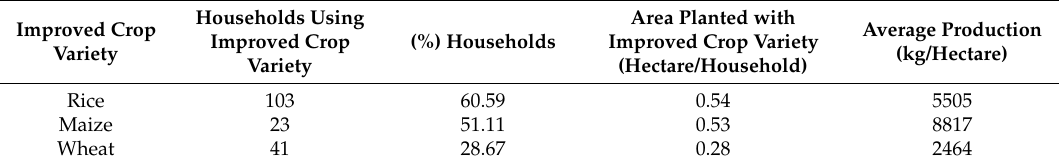
Table 13. Field survey data on use of improved variety of cereals in the study